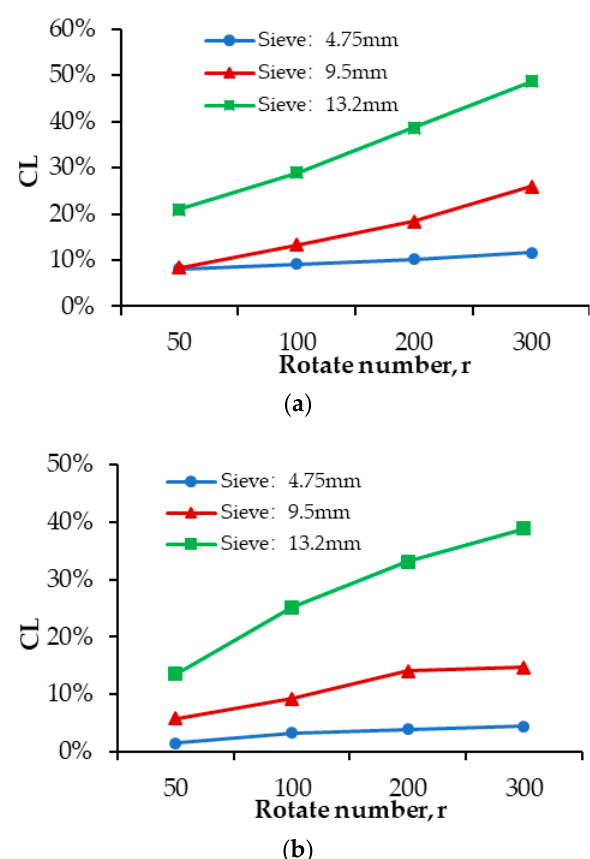
Figure 12. Crushing Loss rate of old ( a ) Open Graded Friction Course (OGFC) materials; ( b ) Stone Mastic Asphalt (SMA) materials.